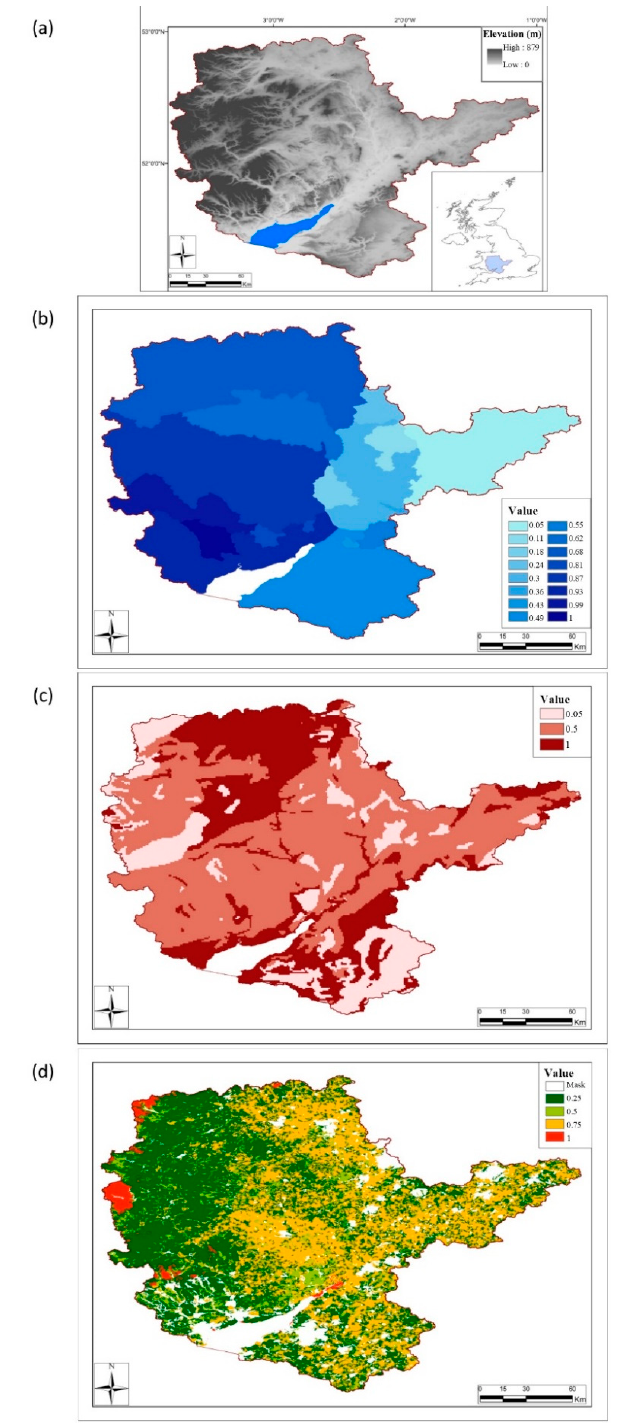
Figure 2. ( a ) Digital Elevation Model (DEM) of the Severn basin in southwestern England (SRTM30). ( b ) Rainfall data: sub-catchments of the Severn basin in the value classes (mean annual precipitation, from catchment daily rainfall (CDR) dataset). ( c ) Soil stability data: soil properties conditions in assigned value classes (from the harmonized world soil database (HWSD) and the British geological survey superficial deposit thickness model (BGS-SDTM)). ( d ) Land use data in associated value classes (from Corine land cover map (CLC), 2018). See text for the explanations.